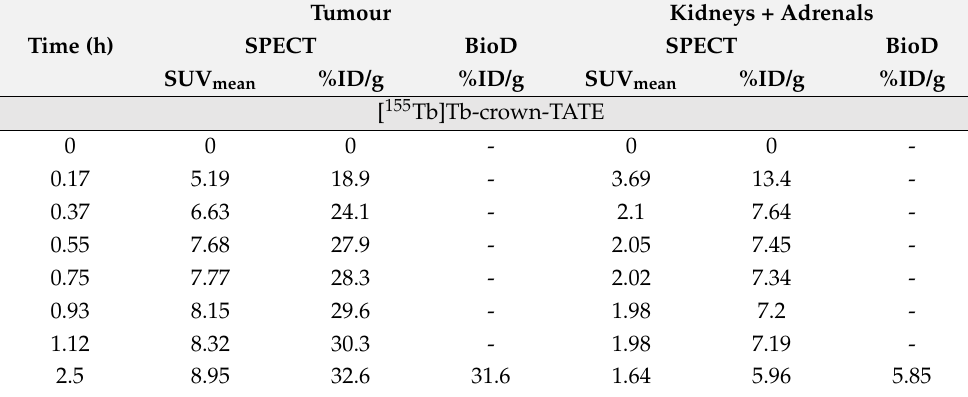
Table 1. Comparison of the activity-concentrations in ROIs as a function of time measured via quantitative SPECT/CT vs. ex vivo biodistribution studies for imaging mice administered